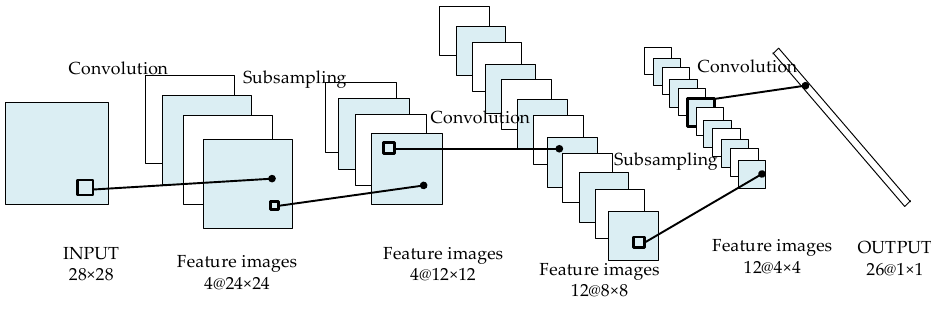
Figure 4. The structure of convolutional neural network.